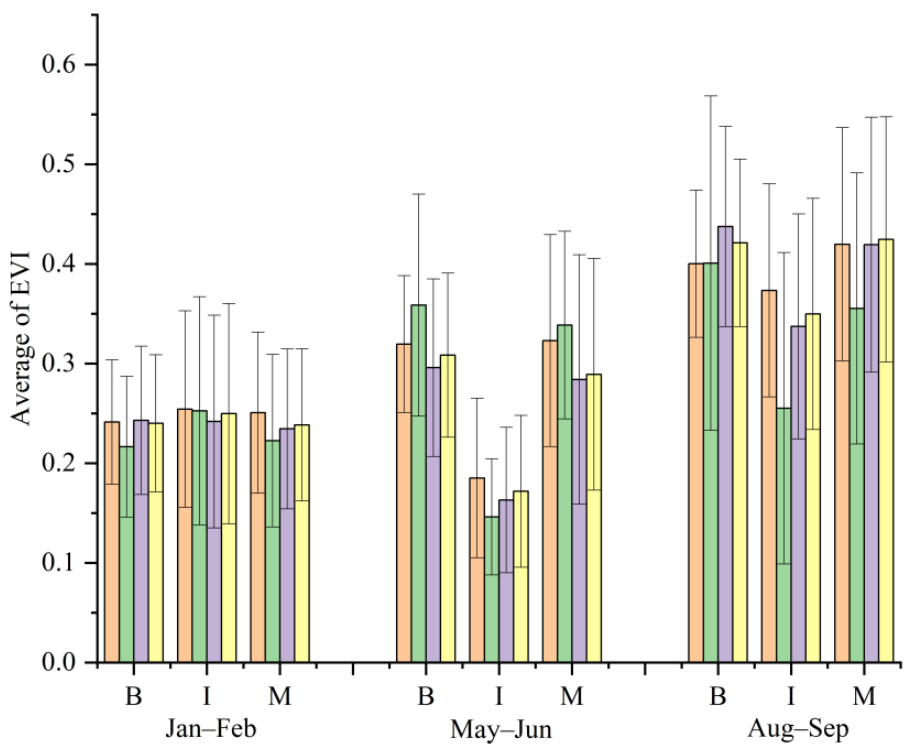
Figure 5. The comparison of the averaged EVI for different meteorological combination events in Bangladesh (B), India (I) and Myanmar (M), with error bars representing standard deviations. (Abbreviations: NTNP–Normal temperature and normal precipitation, HTLP–Higher temperature and lower precipitation, HTNOP–Higher temperature without precipitation, HTHP–Higher temperature and higher precipitation). Table 4. The Analysis of variance (ANOVA) of the impacts of extreme high temperatures on EVI during three growing seasons.